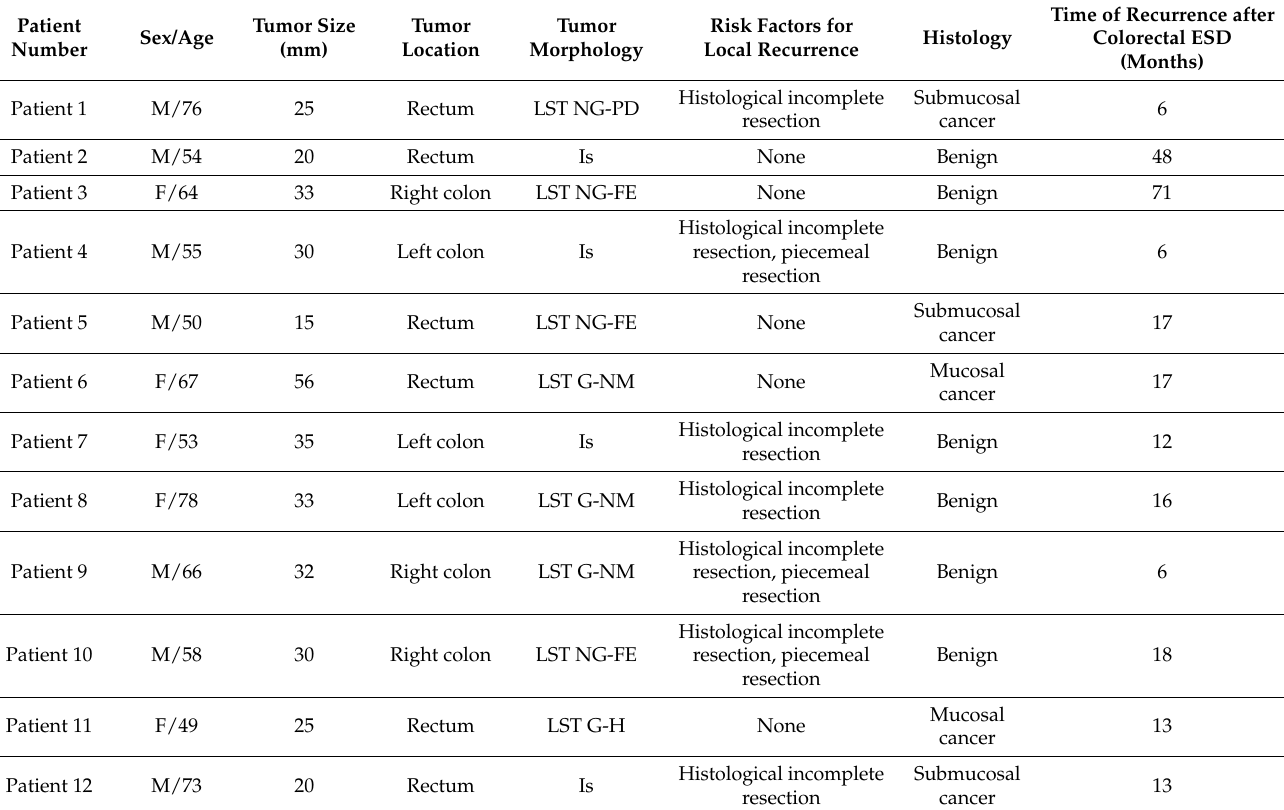
Table 4. Clinical characteristics of 12 patients with local